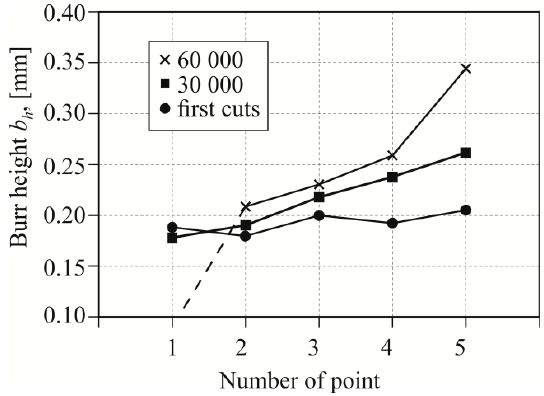
Figure 16. Burr height values measured along the blanking edge for five measuring points ( C = 15%).